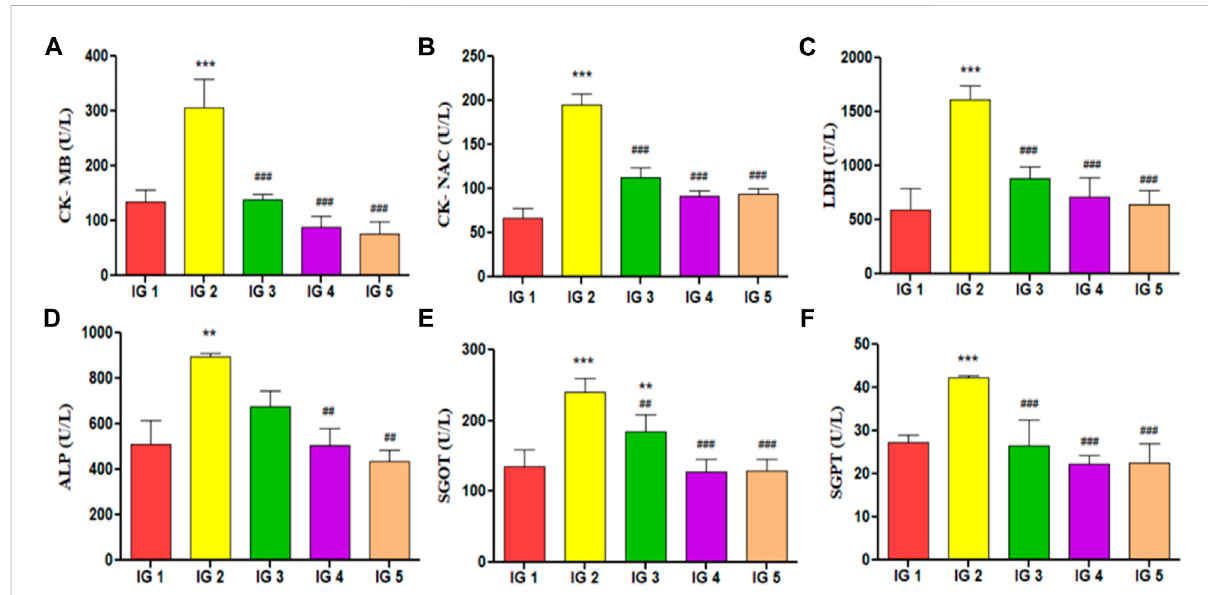
FIGURE 6 The effect of ISO and GC pretreatment on cardiac injury biomarker enzymes in serum of the experimental groups. Results are expressed as mean±SDforgroupsofthreeobservations,statisticallysigni fi cantat*** p < 0.001,** p < 0.01,* p < 0.05ascomparedtoIG1and ### p < 0.001, ## p < 0.01, # p < 0.05 when compared to IG2 as calculated by one-way ANOVA followed by Dunnet ’ s multiple comparison tests. (A) CK-MB, (B) CK-NAC, (C) LDH, (D) ALP, (E) SGOT, (F) SGPT.